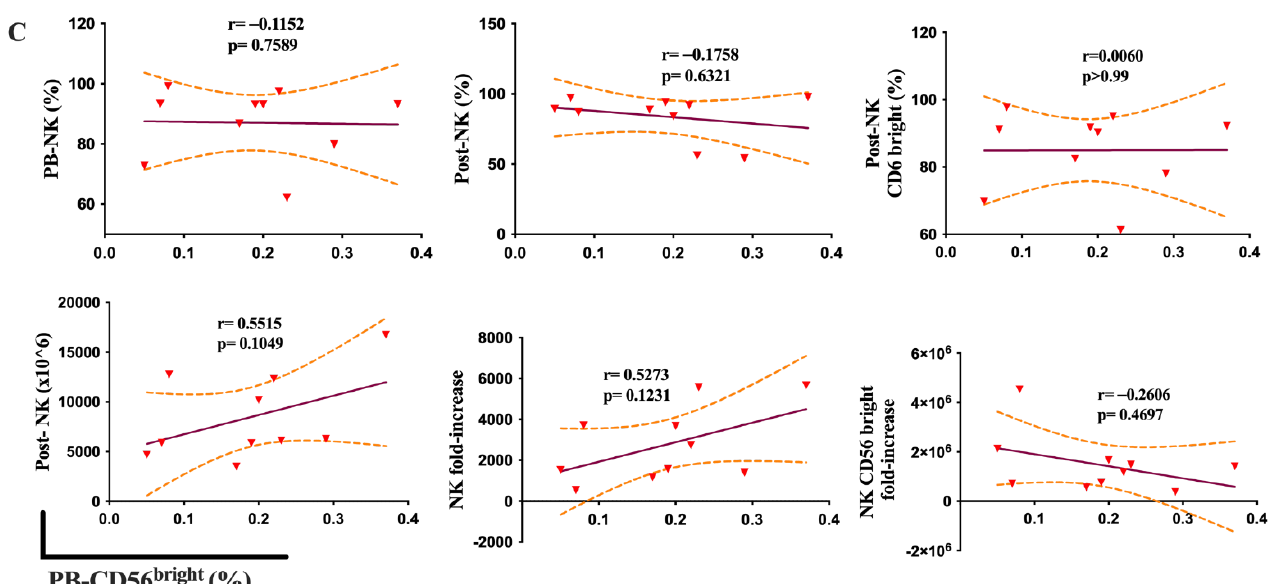
Figure 6. Correlation of peripheral blood indices and the expansion of CD8 + T cells and NK cells in healthy donors. ( A ) The relationship of PB indices and the expansion capacity of CD8 + T cells. ( B ) The relationship between PB indices and the expansion capacity of NK cells. ( C ) Relationship of PB- CD56 bright NK (%) with NK cell growth. Spearman’s rank coefficient was used for correlation analysis and non-linear regression was also applied. Median values and interquartile ranges were plotted in graphs. Significance levels were set to p < 0.05. PB: Peripheral blood; Pre-: At seeding; Post-: After